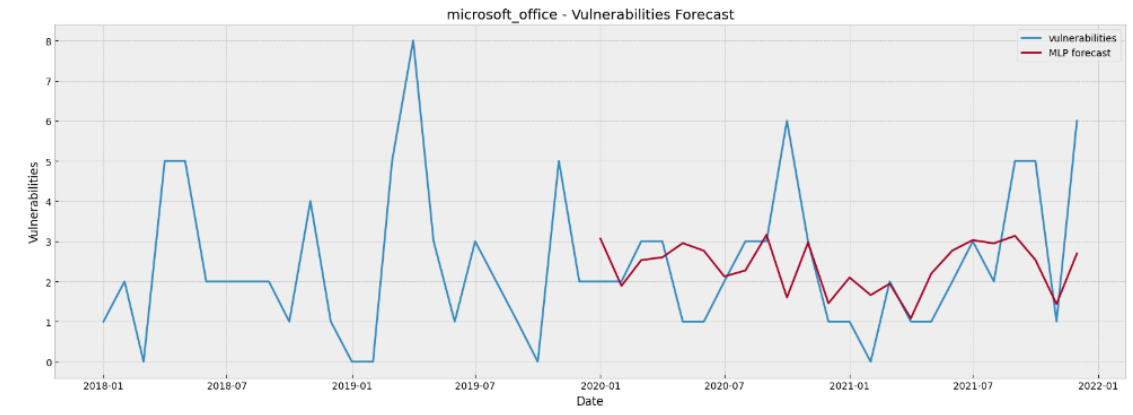
Figure 8. Microsoft Office vulnerability forecasting for 24 steps ahead using